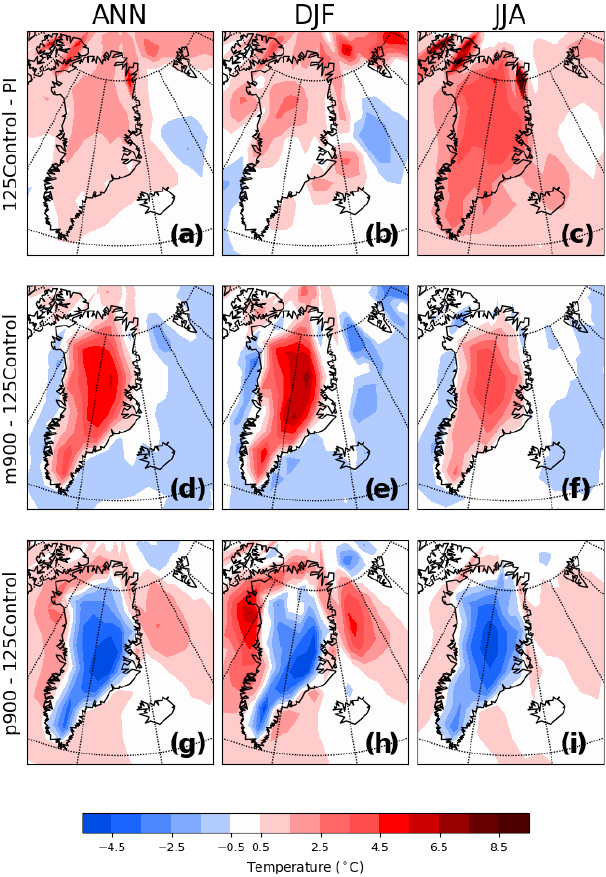
Figure 2. Modelled annual (ANN), winter (DJF) and summer (JJA) surface air temperature anomalies for m900 (d–f) and p900 (g–i) compared to the 125Control simulation. Also shown are tempera- ture anomalies for 125Control compared to the PI simulation (a–c) . Only the anomalies statistically significant at the 95% confidence level are